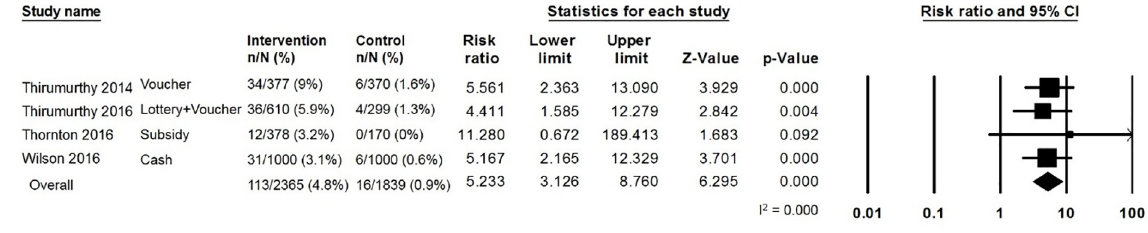
Fig 2. Meta-analysis results: Risk ratio of uptake of VMMC from RCTs, overall.